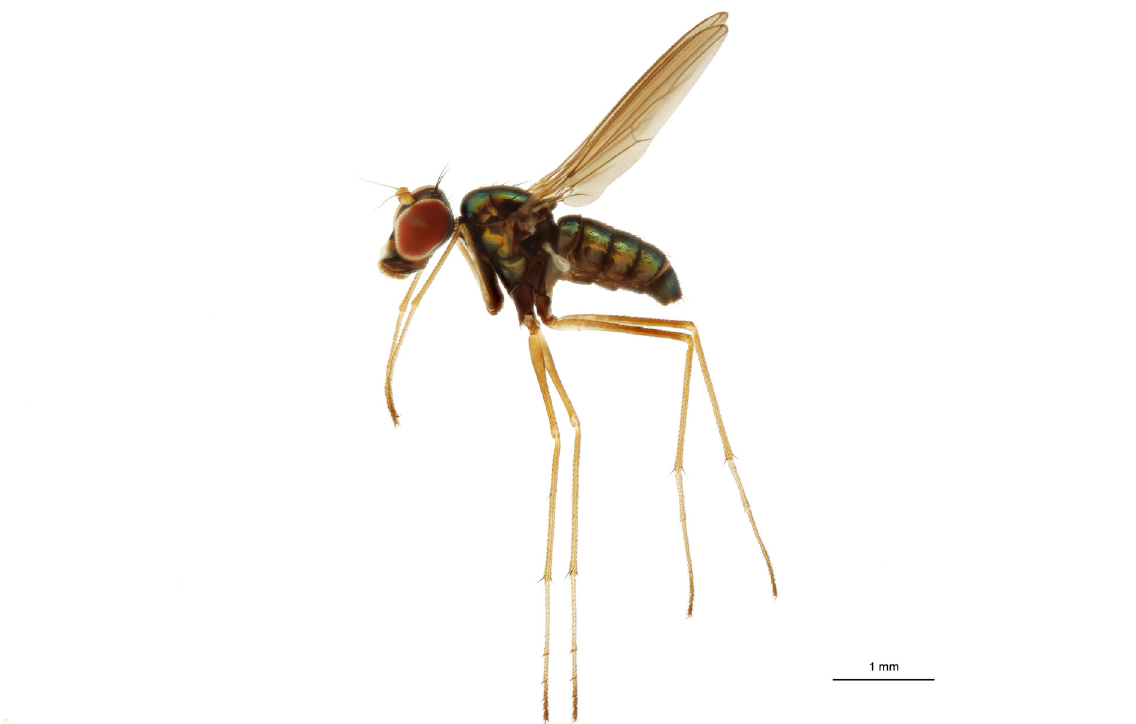
Fig. 9. Thinophilus subapicalis Samoh & Grootaert sp. nov. Female habitus (Abdulloh Samoh leg., PSUNHM